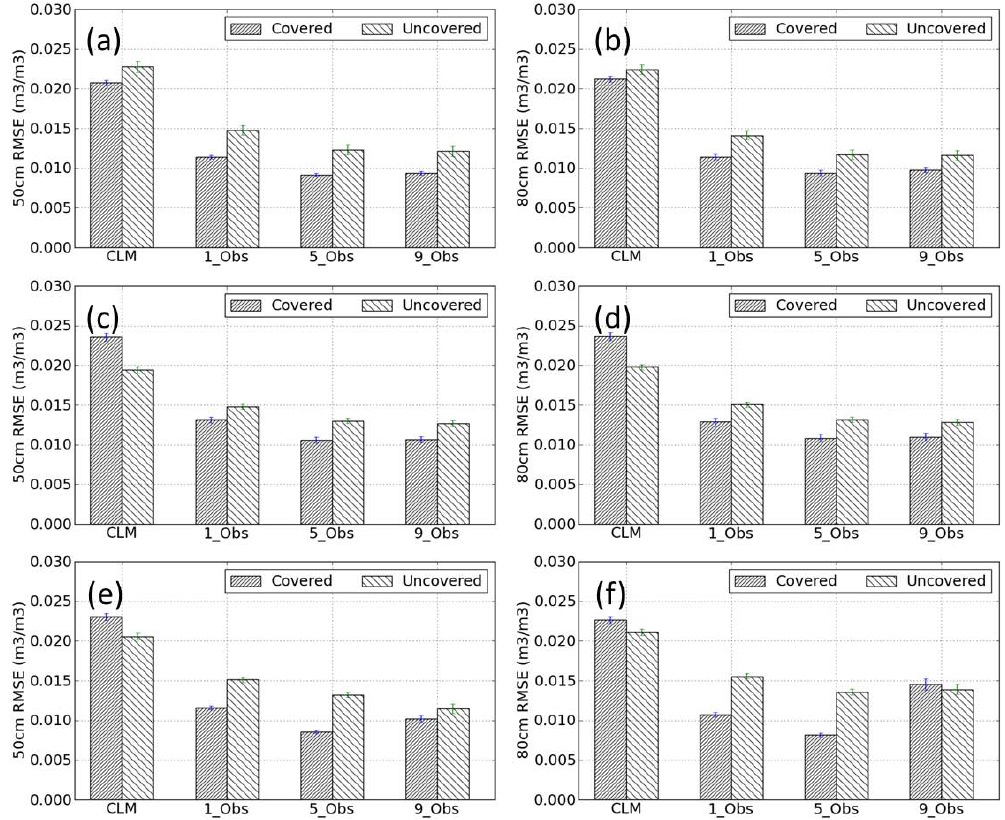
Fig. 4. Mean RMSE values of soil moisture (including 95% confidence intervals) for open loop simulations (CLM) and three assimilation strategies of 1 observation used (1 Obs), 5 observations used (5 Obs) and 9 observations used (9 Obs) for 50cm and 80cm depth. Results are shown for 70% – 50cm (a) , 80cm (b) – 47% – 50cm (c) , 80cm (d) – and 31% – 50cm (e) , 80cm (f) – observational